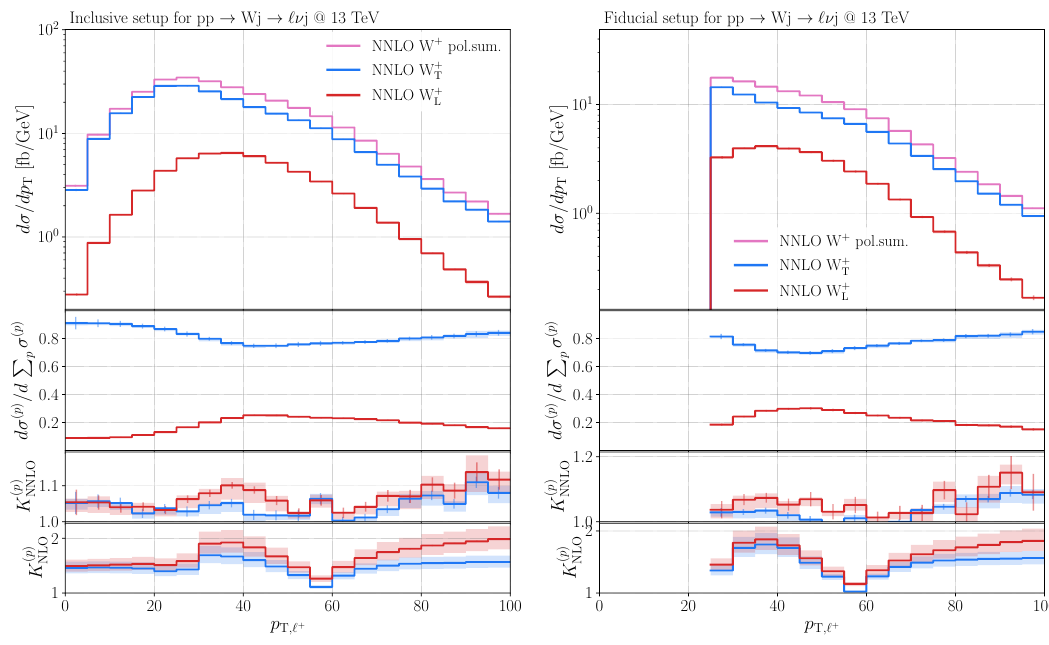
. Same plot structure as in figure T ,‘ +